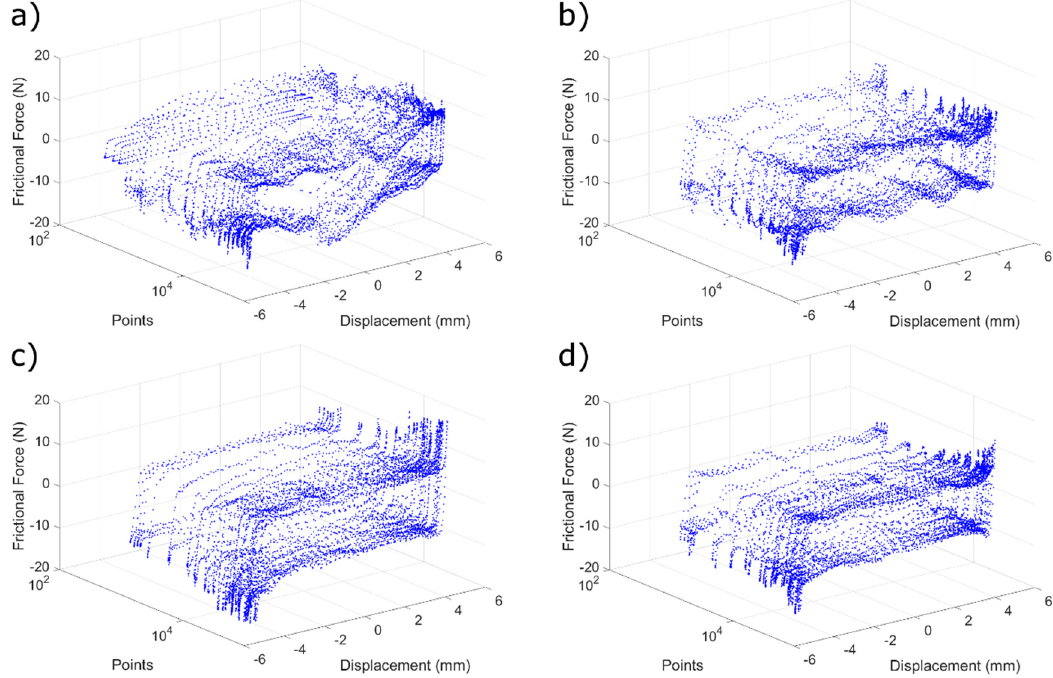
Figure 7. Loop cycles of the frictional force for: ( a ) aluminium; ( b ) titanium plate; ( c ) titanium coating; ( d ) laser ‐ treated coating cases.